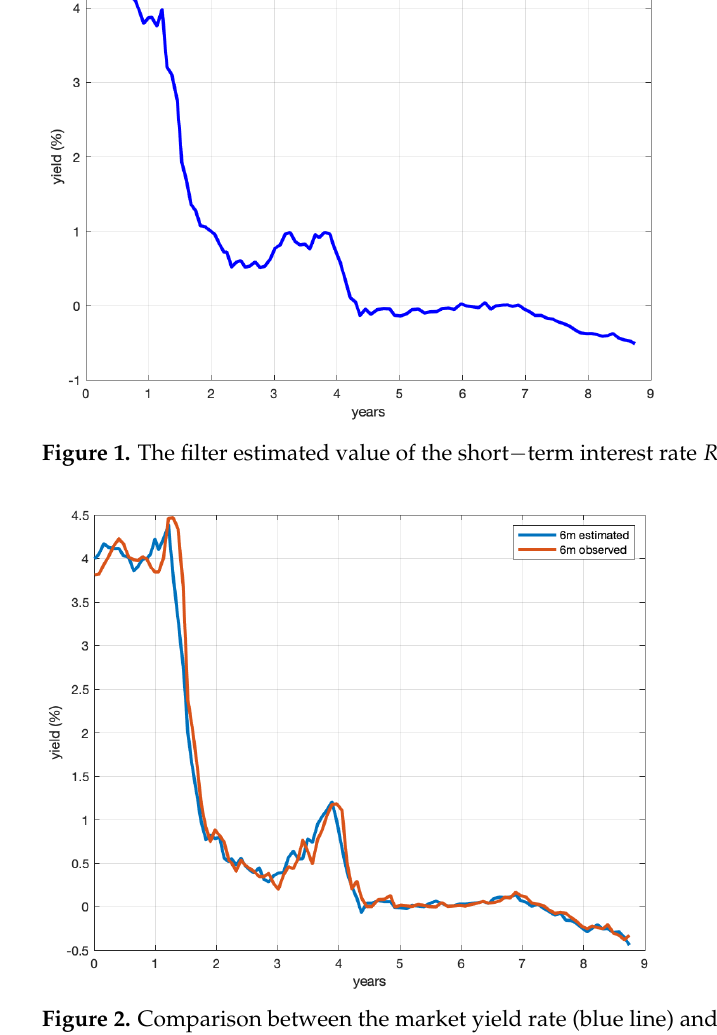
Figure 2. Comparison between the market yield rate (blue line) and the model − implied yield rate (red line) for the 6-month